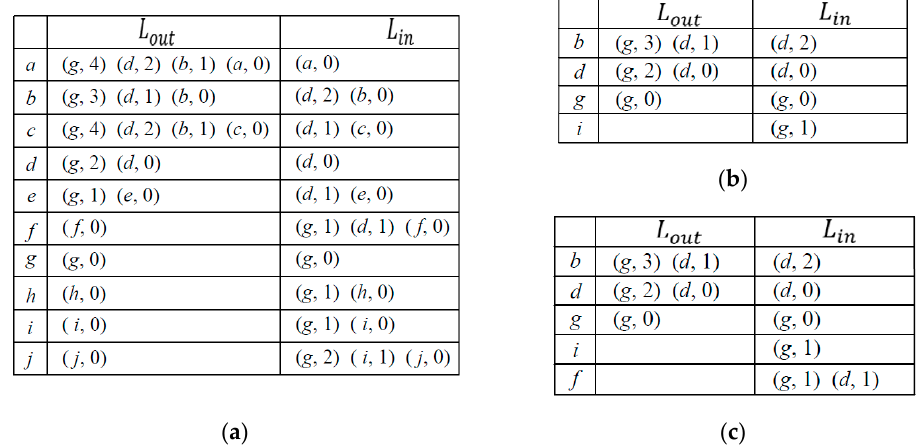
Figure 2. Illustration of different labels. ( a ) Constructing labels based on all vertices. ( b ) Baseline approach. ( c ) Degree constraint.